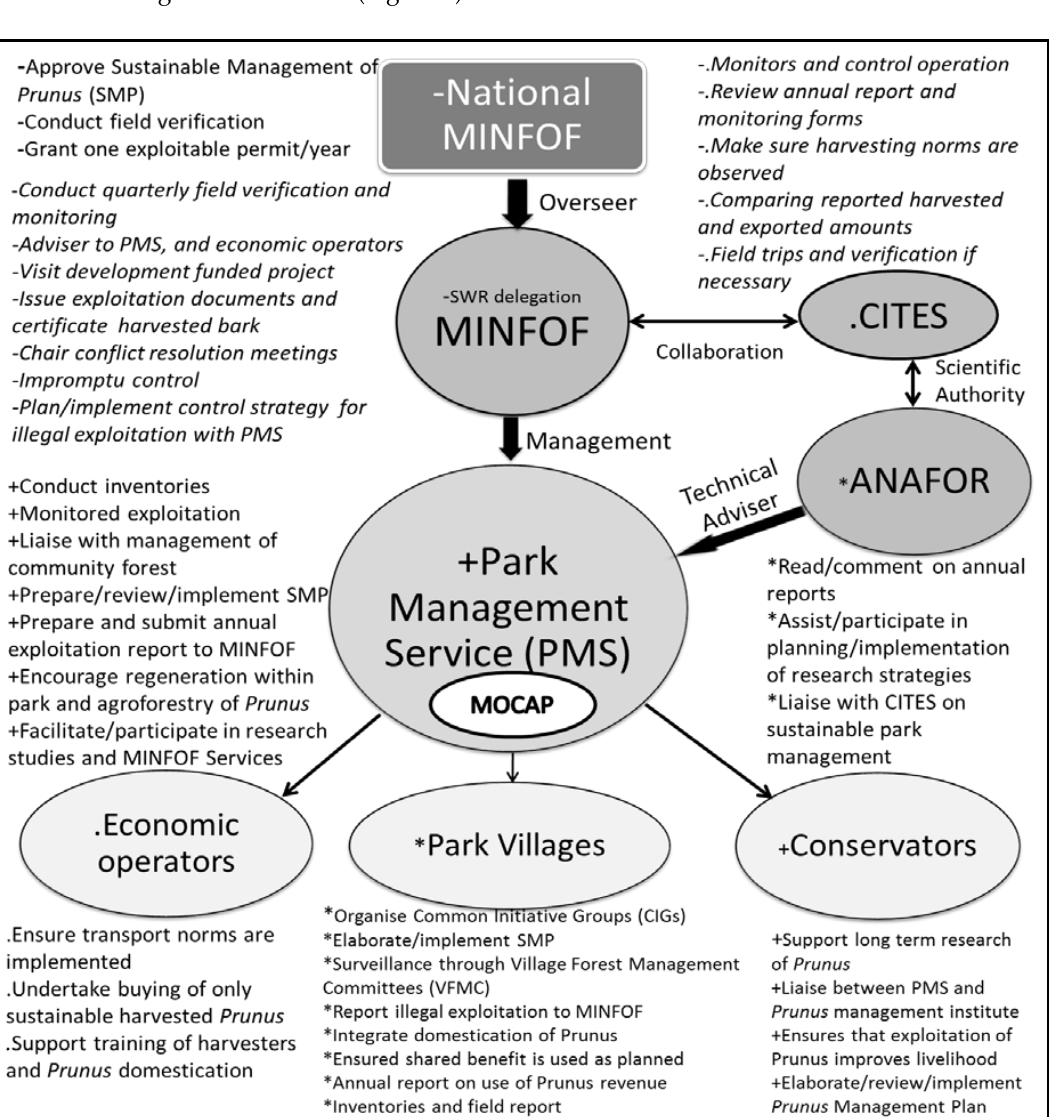
Figure 5. Roles and responsibility of stakeholders in sustainable management of Prunus . MINFOF, Ministry of Forestry and Fauna; MOCAP, Mount Cameroon Prunus ; CITES, Convention on International Trade in Endangered Species of Fauna and Flora; ANAFOR: National Forest Development